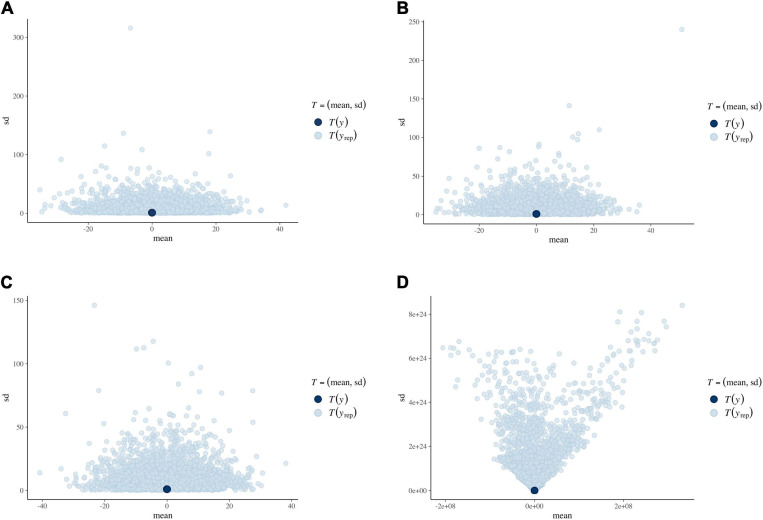
Means (x-axis) and standard deviations (y-axis) in the prior predictive distribution for the four prior specifications. The dark-blue dots represent the means in the imputed observed datasets (centered at 0). (A) Linear pool. (B) Logarithmic pool. (C) Fitted normal distribution. (D) Default.